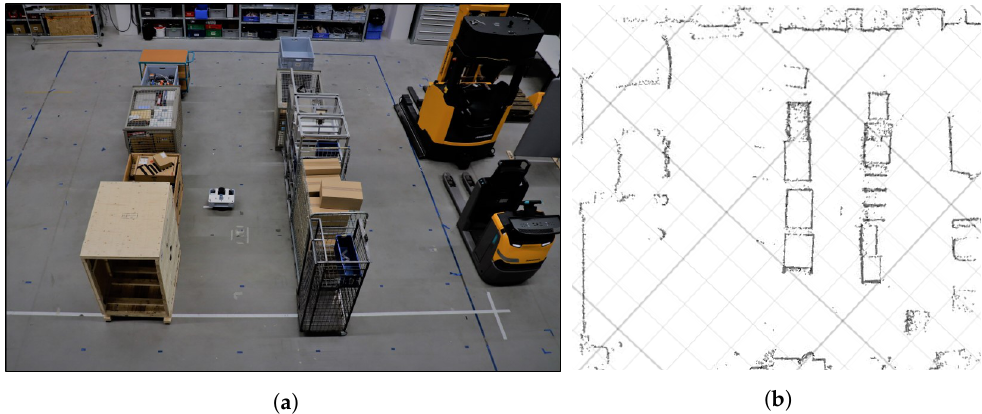
Figure 14. ( a ) Setup of the environment at the Institute for Technical Logistics. ( b ) Recorded map from the LiDAR ILS. The grid with a grid length of 1 m is aligned with the map coordinate